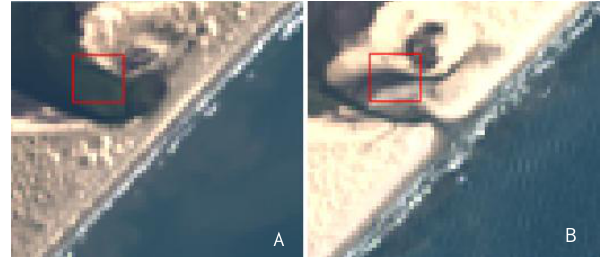
Figure 4. The training sample area (red line) over the color composite for the 08/30/2013, closed (A), and 12/15/2017, open channel (B) situations.